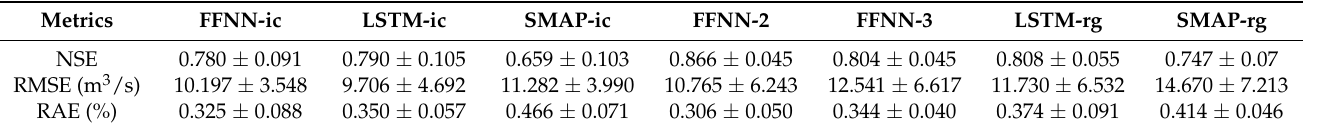
Table 4. Median of models’